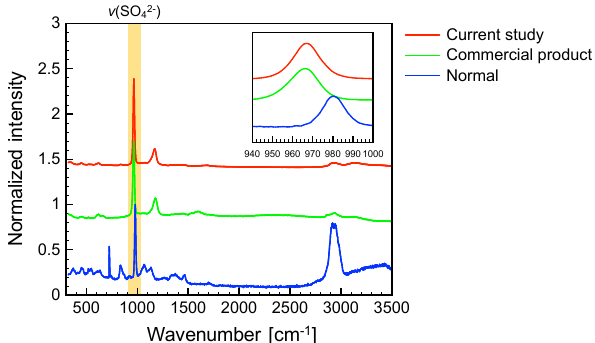
Figure 4. Normal (blue) and enhanced (green, commercial product; red, current SERS) Raman spectra of the AS / sucrose particles. In- set frame is an enlarged view of spectra at 940–1000cm − 1